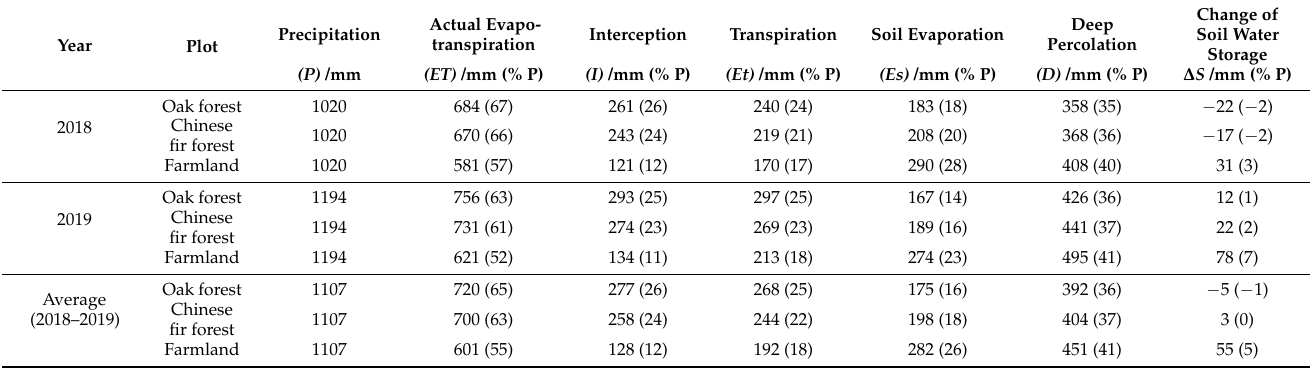
Table 4. Simulated annual water balance (in mm) with